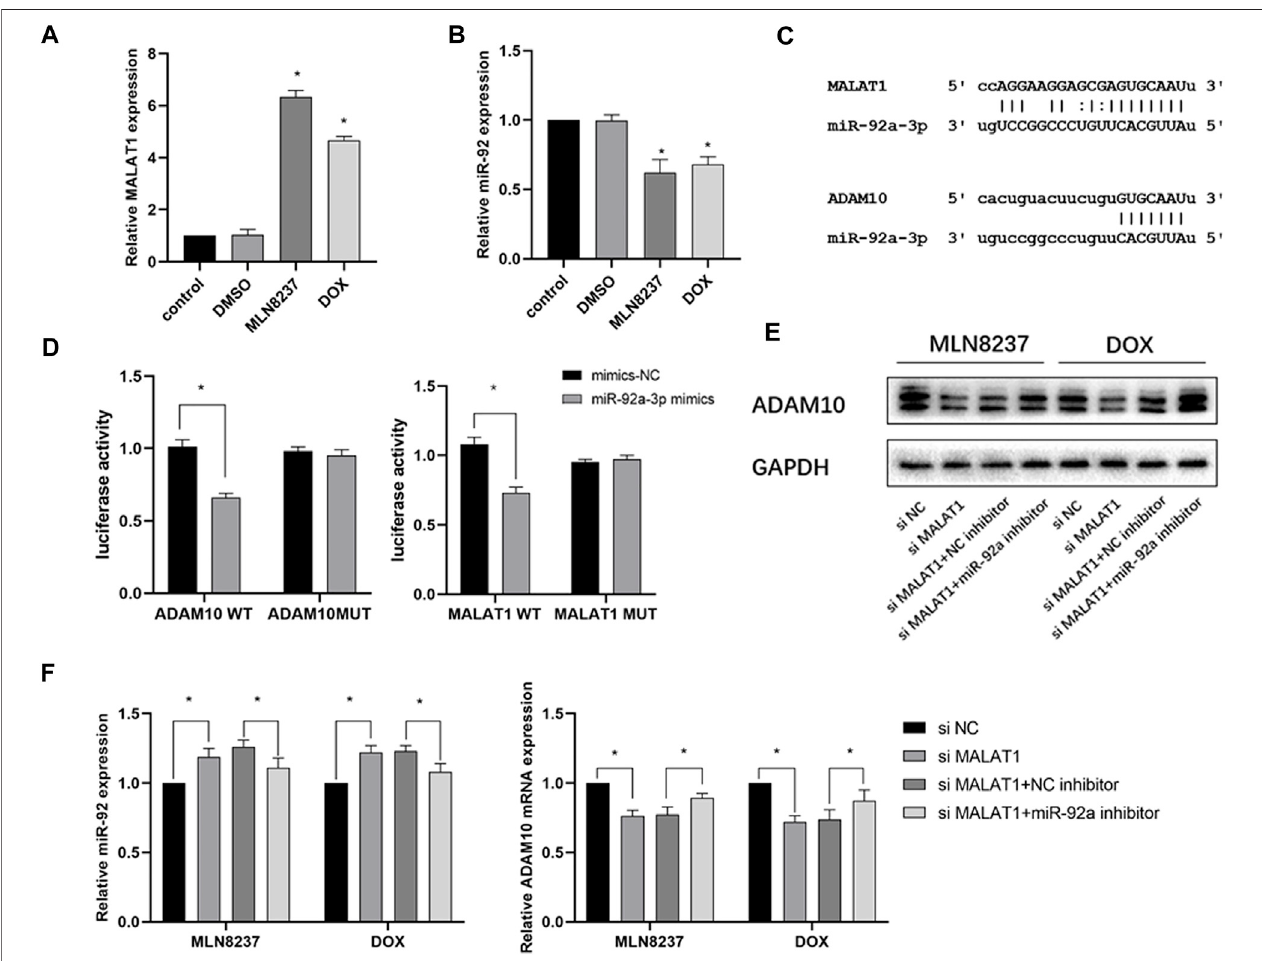
FIGURE 5 | The MALAT1/miR-92a-3p axis regulates ADAM10 expression. (A) IMR-32 cells were treated with 2 μ M MLN8237, 0.5 μ M DOX, DMSO, or no treatment as a control. (B) After 72 h, miR-92a-3p and ADAM10 expression was detected by qRT-PCR. (C) Prediction of binding sites between miR-92a-3p and MALAT1 and thosebetweenmiR-92a-3p and ADAM10 usingENCORI. (D) Con fi rmation ofmiR-92a-3pbindingto ADMA10 andMALAT1 wascon fi rmedbyluciferase- reporterassayusing293Tcells. (E) IMR-32wasco-transfectedwithanmiR-92a-3pinhibitorandsi-MALAT1,andADAM10levelwasdetectedbywesternblot. (F) The expression of miR-92a-3p and ADAM10 was detected by qRT-PCR. Data represent the mean ± SEM of three independent experiments. * p < 0.05.